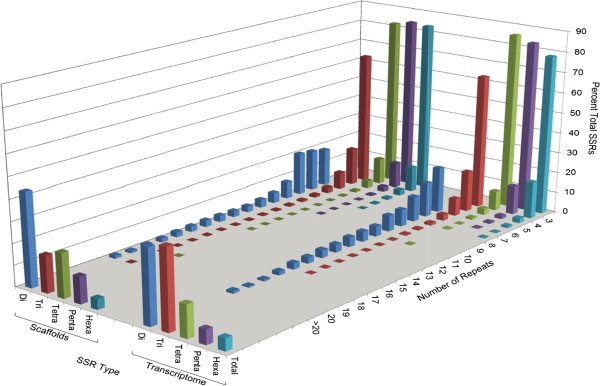
Microsatellite (Simple Sequence Repeat; SSR) markers. Occurrence and distribution in the cranberry genome and unigene (transcriptome) sequences.